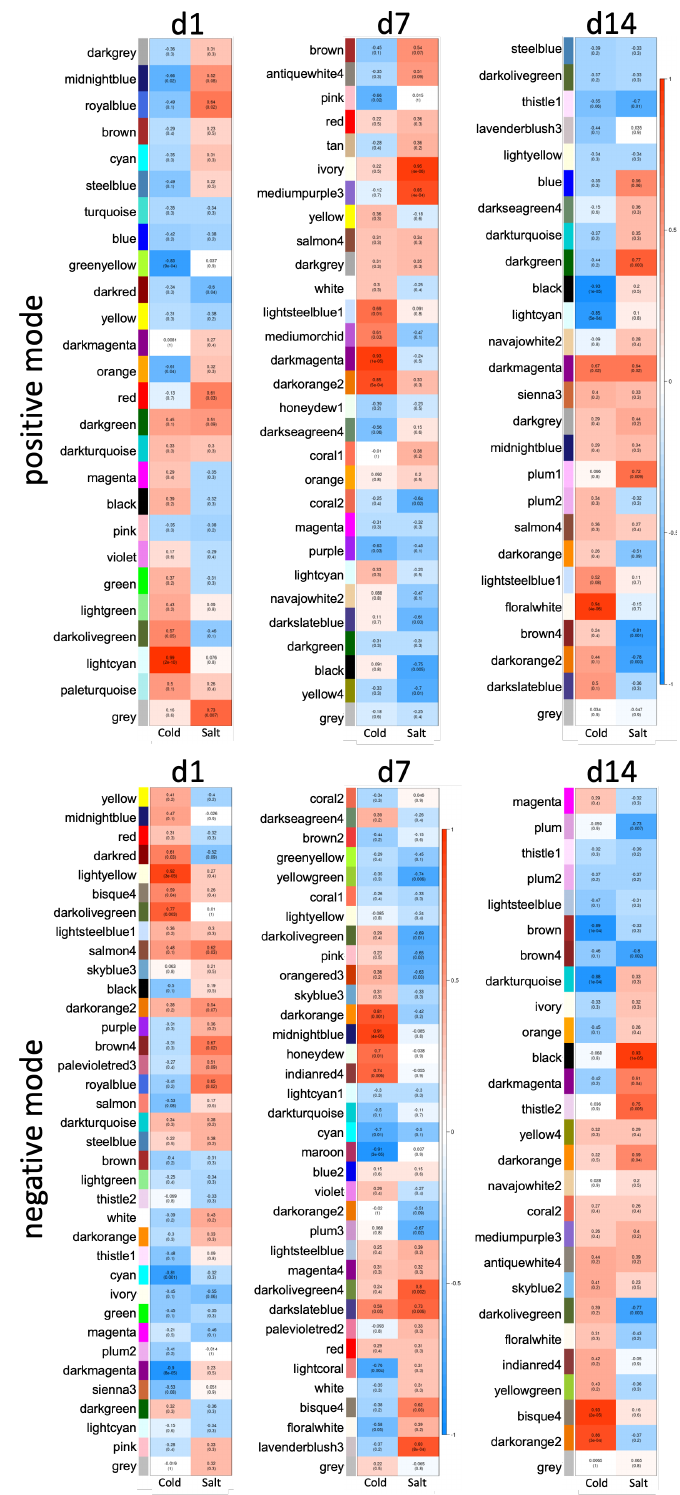
Figure A12. Module-trait correlation for the metabolome of Mazurka. Metabolic data (positive and negative mode) was used to perform a WGCNA . Shown here is the relationship for each identified cluster with the single stress chilling temperature (Cold), or salt (Salt) as indicated at d1, d7, or d14. On the y-axis, all identified modules are listed with their respective names. Color and number indicate the correlation between module and binary trait for eigengenes and numbers in brackets the p-Value for significance.